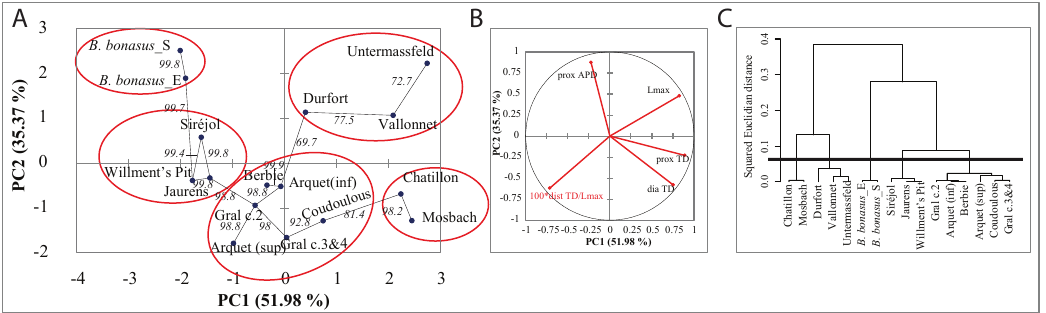
Figure 5. Principal component analysis of the modified variable size index of Pleistocene and Holocene European bison metacarpal. ( A ) PCA of the VSI*. The most robust connections between samples were established using the bootstrapped spanning network [31] and the bootstrap values of the simplest connected network best supported by the data are indicated alongside the links. The red circles indicate the clusters identified using the HAC data shown in panel C. For sample description, see legend of Figure 4. ( B ) Correlation circle of the coefficients of the first two principal components showing the relationships between the variables. ( C ) HAC with Ward’s minimum variance method using, for each population, the squared Euclidian distance between the first two components of the PCA. The optimal number of clusters minimizing total intra-cluster variation was determined using a distance criterion and the elbow method. The threshold distance identified is indicated with a thick black